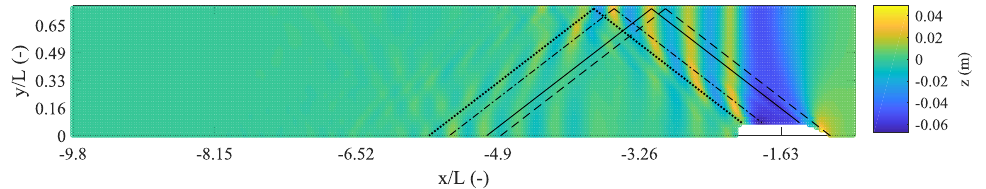
Figure 10. Generated wave field in the rectangular canal at 𝐹 ℎ = 0.77 and corresponding half-angle according to Havelock [26]. Dashed line originates at FP; solid line originates at the nearest downstream peak, where the dashed line is reflected. Broken line originates at the highest wave elevation on the wall; dotted line originates at the ship coordinates representing the point where the aft wave system is generated.